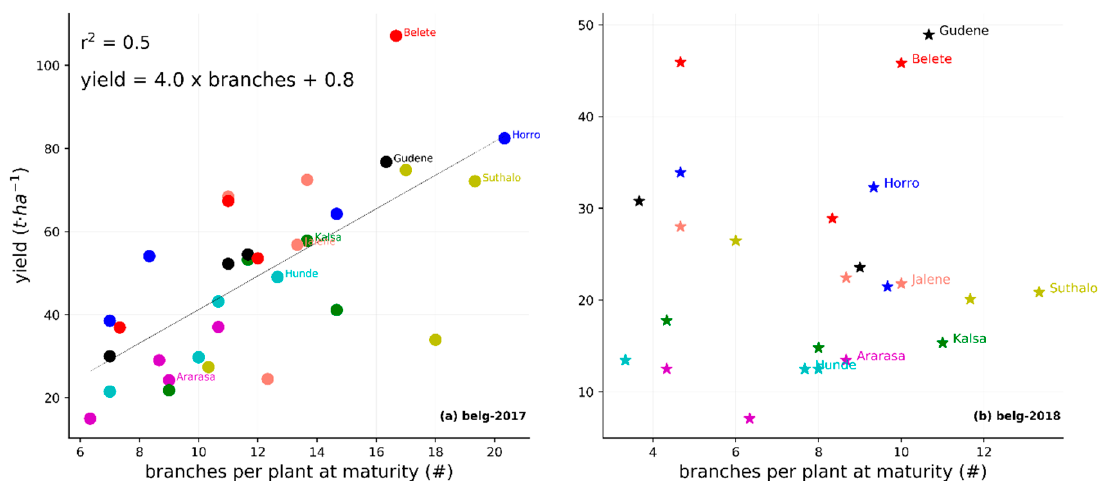
Figure 8. Variations in the observed yield (t · ha − 1 ) for eight cultivars as a function of total number of branches at maturity (#). The colors represent cultivars in four locations in belg -2017 ( a ) and six locations in belg -2018 ( b ). The linear coefficient of correlation ( r 2 ) and the linear regression equation are shown in ( a ); and no clear correlation is observed in ( b ). Note that scales along x and y-axes are different for both panels.